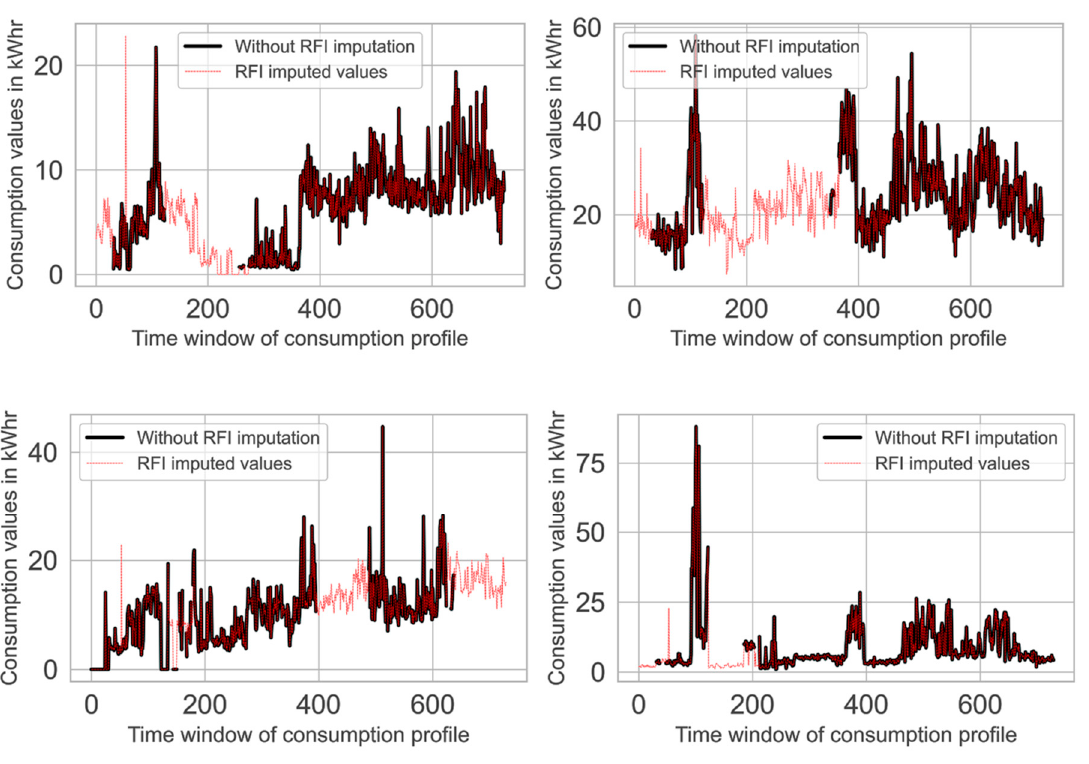
Figure 6. Missing value imputations using the random forest imputer.